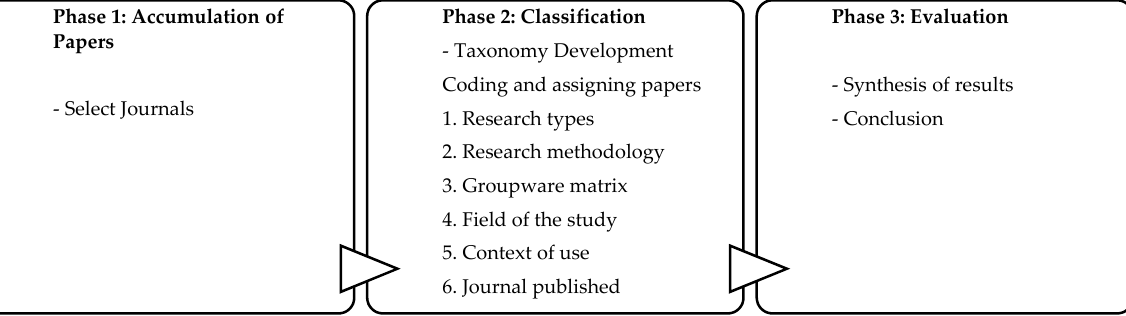
Figure 2. Research method of the study (Adapted from